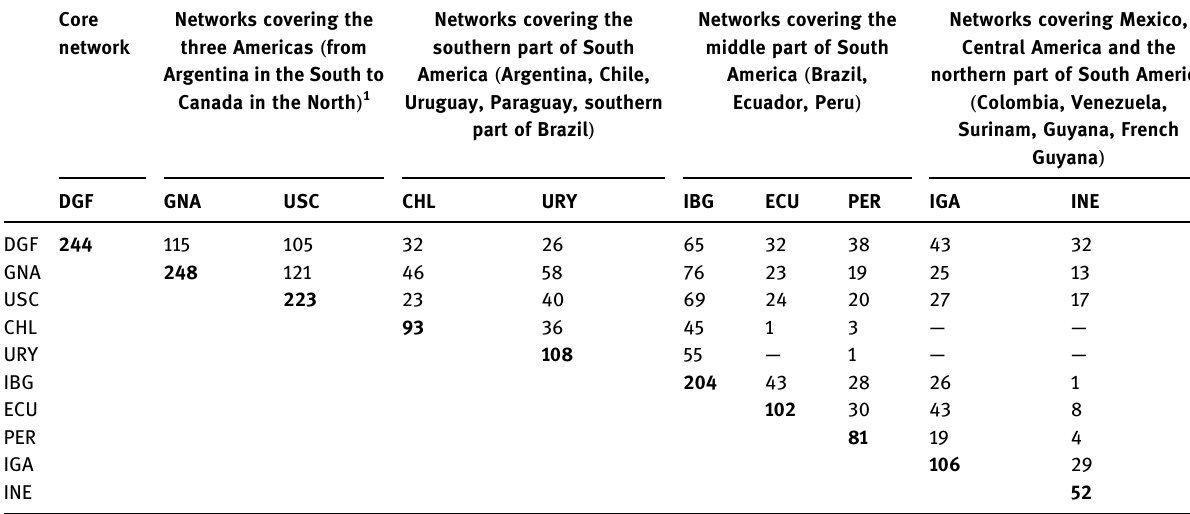
Networks covering the